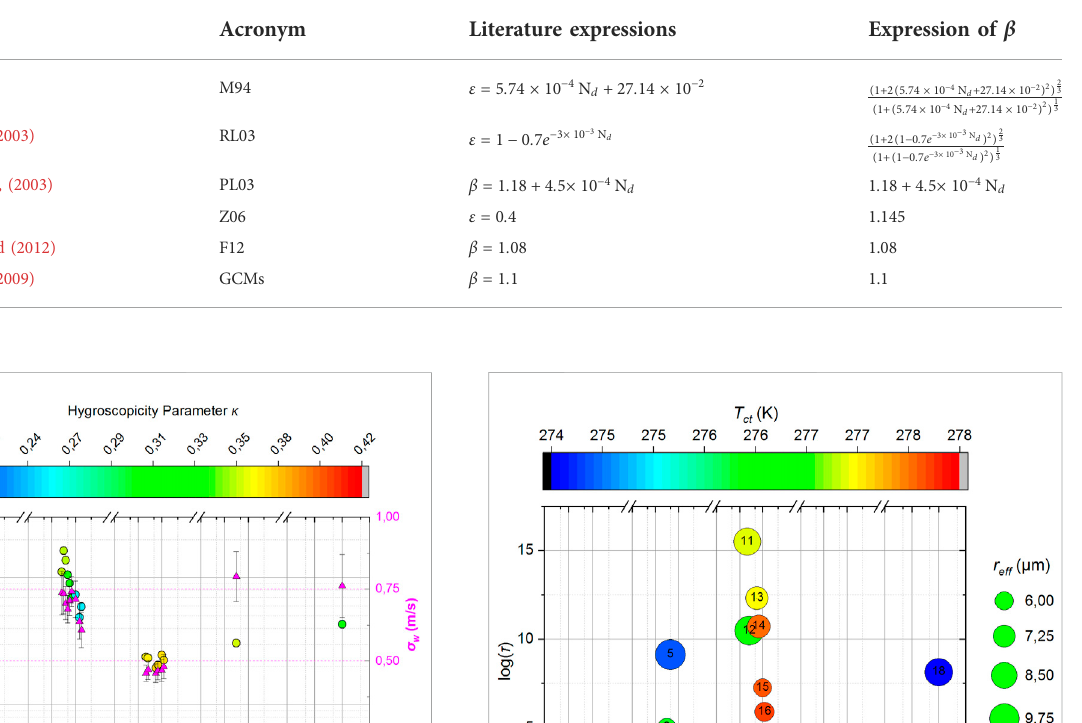
TABLE 2 β -expressions based on literature according to: 1) Martin et al. (1994) — M94, b) Rotstayn and Liu (2003) — PL03, c) Peng and Lohmann, (2003) — PL03, Zhao et al. (2006) — Z06, d) Freud and Rosenfeld (2012) — F12 and e) GCMs studies – Rotstayn and Liu (2009), respectively.